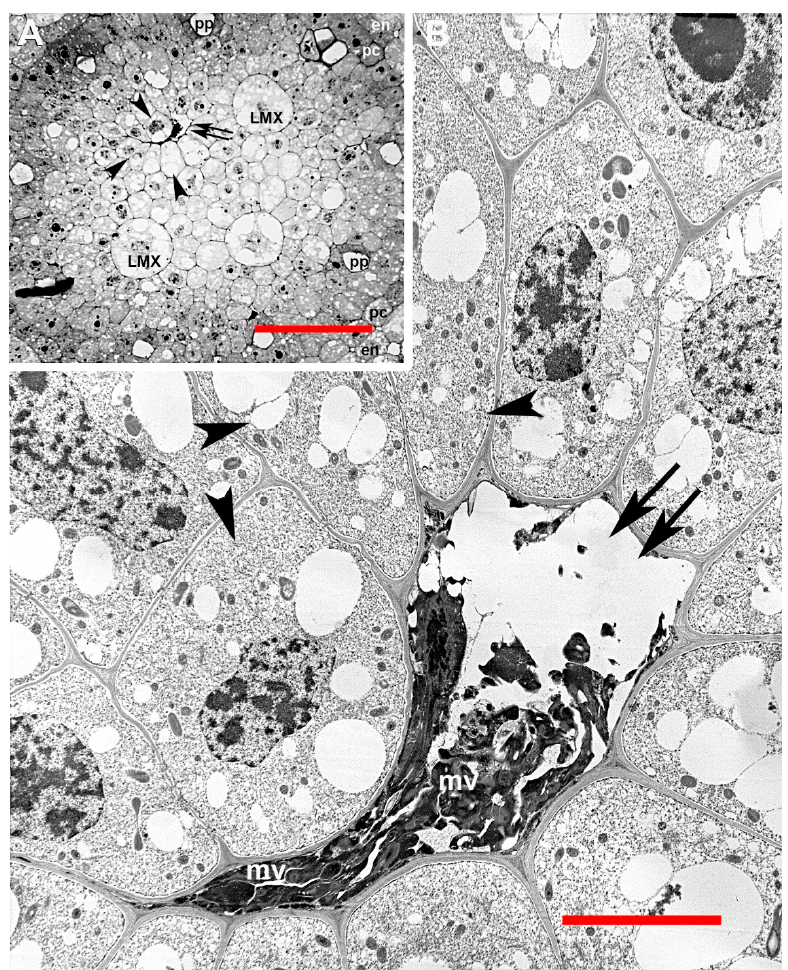
Figure 6. Collapse of LMX during abnormal development. ( A ) Light micrograph of a transverse section with one of four LMX elements in a state of collapse. Scale bar = 50 µm. ( B ) Highly magnified transmission electron micrograph featuring the same abnormal vessel element as shown in Figure 6A filled with dense, irregular macrovesicles (mv). LMX, unaffected late metaxylem vessel element; double arrow, collapsing late metaxylem vessel element; arrowhead, distorted and enlarged xylem parenchyma cells surrounding a collapsing late metaxylem vessel element; pc, pericycle; en, endodermis; pp, protophloem. Scale bar = 10 µm.